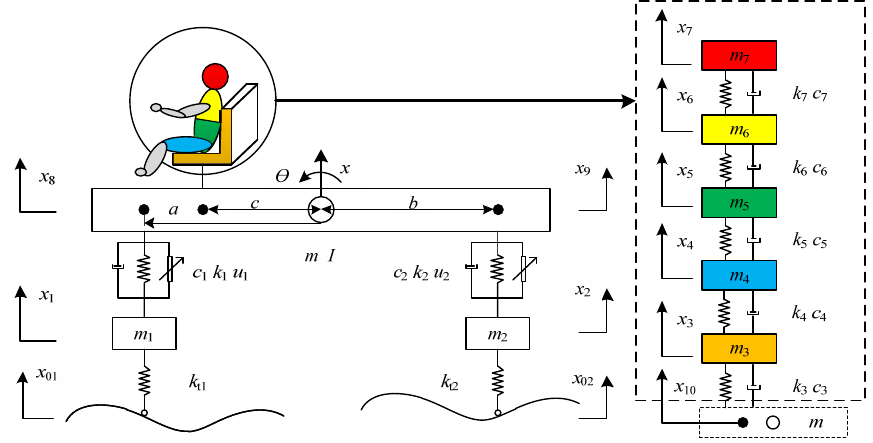
Figure 2. Semi-vehicle driver-active suspension model.